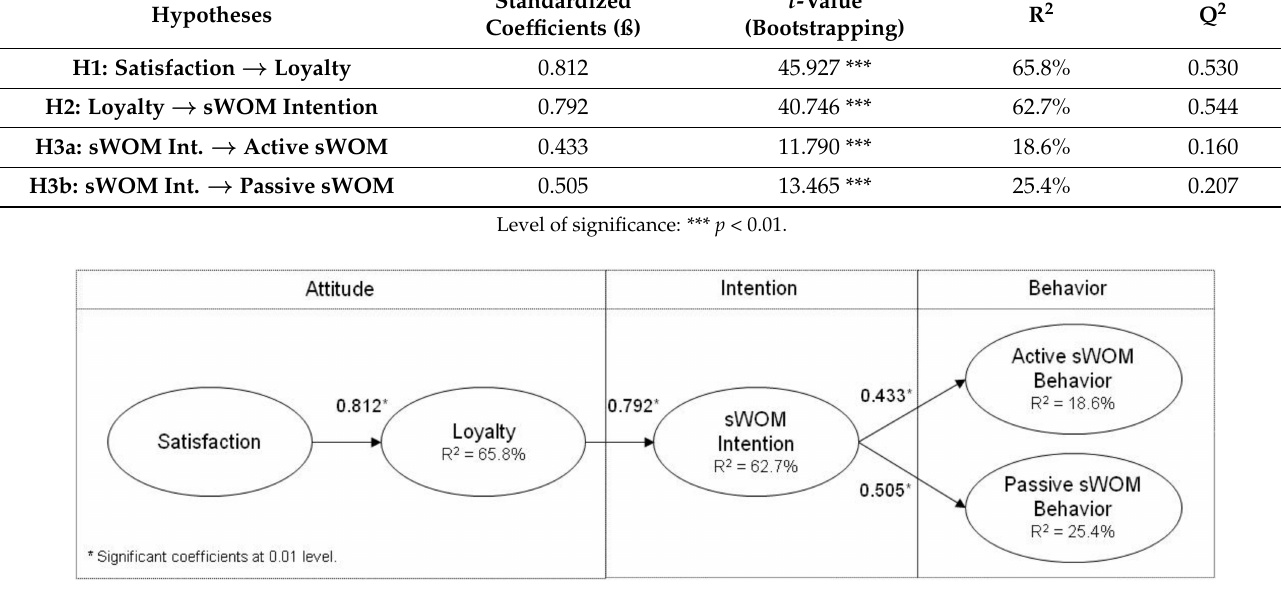
Figure 2. Structural